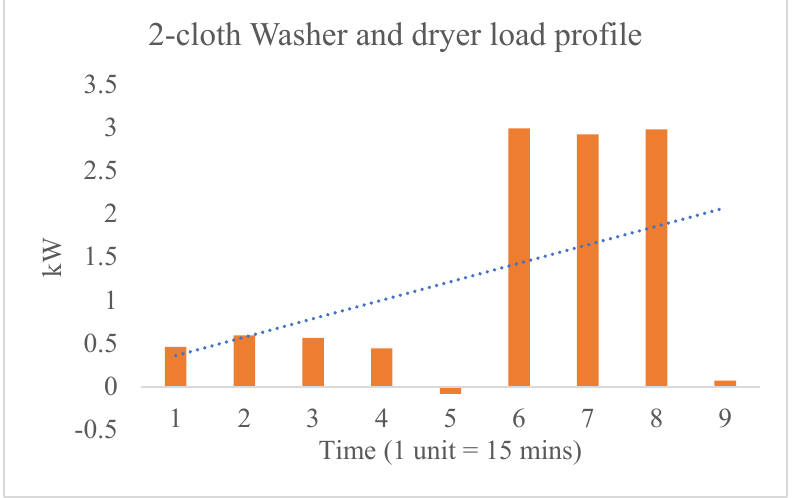
Figure 5. Washer and dryer load profile.